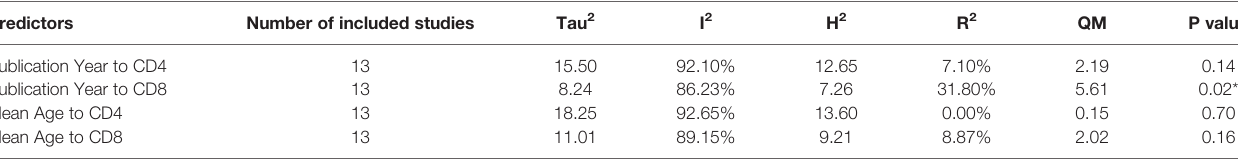
TABLE 3 | The meta-regression analysis for the Mean Age and Publication Year to CD4 and CD8.